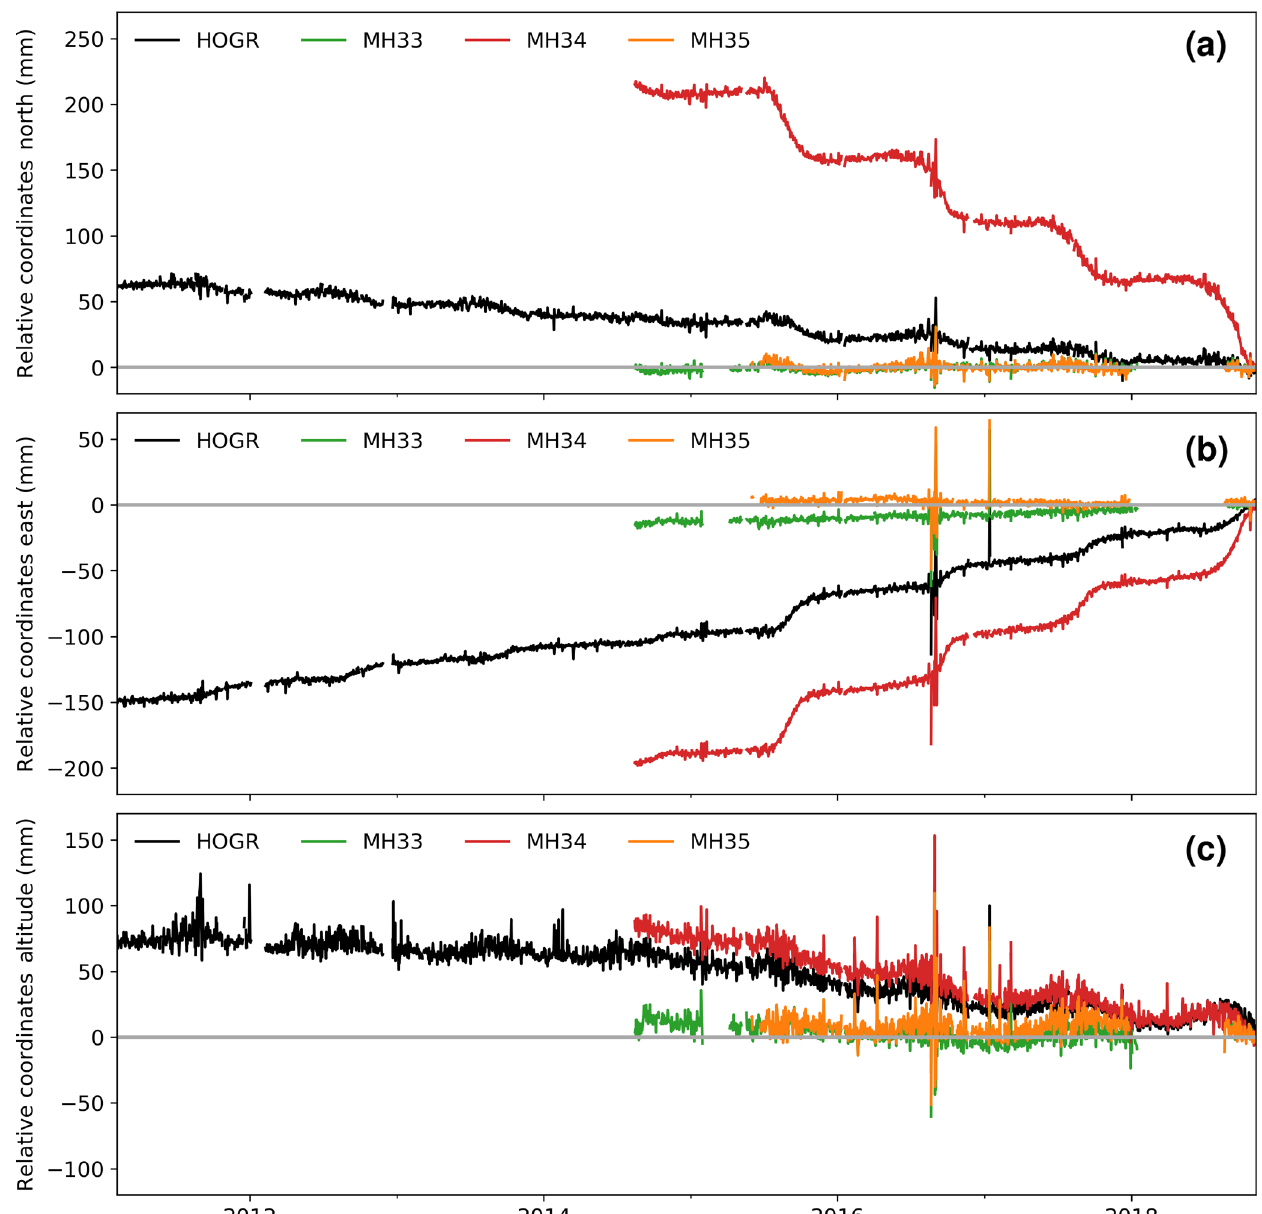
Figure 15. Relative displacement of the GNSS positions measured at the Matterhorn Hörnligrat. For an approximate overview of the measurement setting, see Figs. C11 and